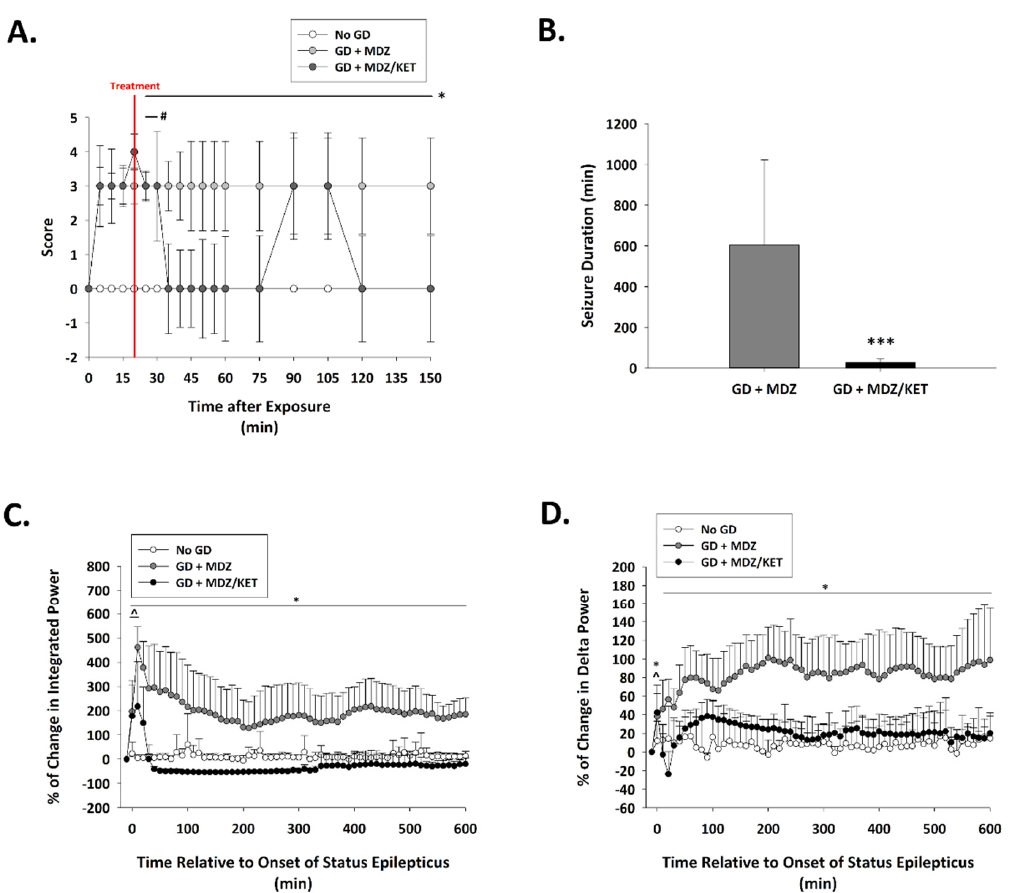
Figure 5. Effect of ketamine as an adjunct to delayed midazolam treatment on seizure activity and severity in soman-exposed KIKO mice. ( A ) SC exposure to 80 µ g/kg of GD resulted in the appearance of behavioral seizure signs within 5 min of exposure. The severity of toxic signs was scored following a modified Racine scale: 0, no abnormality; 1, mastication, tongue fasciculations, oral tonus; 2, head nodding and/or tremors; 3, forelimb clonus or tonus, body tremors; 4, rearing with convulsions; and 5, rearing and falling with convulsions. Following treatment administration (indicated by a red line; 15 min after EEG seizure onset), toxic signs for the midazolam/ketamine group (GD + MDZ/KET; n = 13) were transiently reduced in severity within 15 min of treatment for up to 40 min after treatment. In contrast, toxic signs in the midazolam monotherapy group (GD + MDZ; n = 15) did not subside. * p < 0.05, GD + MDZ compared to no agent control (No GD; n = 6); # p < 0.05, GD + MDZ/KET compared to No GD. ( B ) Soman exposure elicited seizure that had an average duration of ( ± SD) 705.3 ± 332.4 min in the GD + MDZ ( n = 13) group, while an average of 29.4 ± 23.4 min was observed in the GD + MDZ/KET ( n = 13) group. *** p < 0.001, GD + MDZ compared to no agent control (No GD); Tracings of average percentages of relative change in ( C ) integrated power (freq. range) and ( D ) delta (0.1–4 Hz) EEG frequency are shown over a period of 600 min (10 h). In KIKO mice, the midazolam/ketamine combination therapy was able to reduce over time the increase in integral power and delta power immediately following administration of treatment. * p < 0.05, GD + MDZ ( n = 7) compared to No GD ( n = 5) group; ˆ p < 0.05, GD + MDZ/KET ( n = 5) compared to No GD